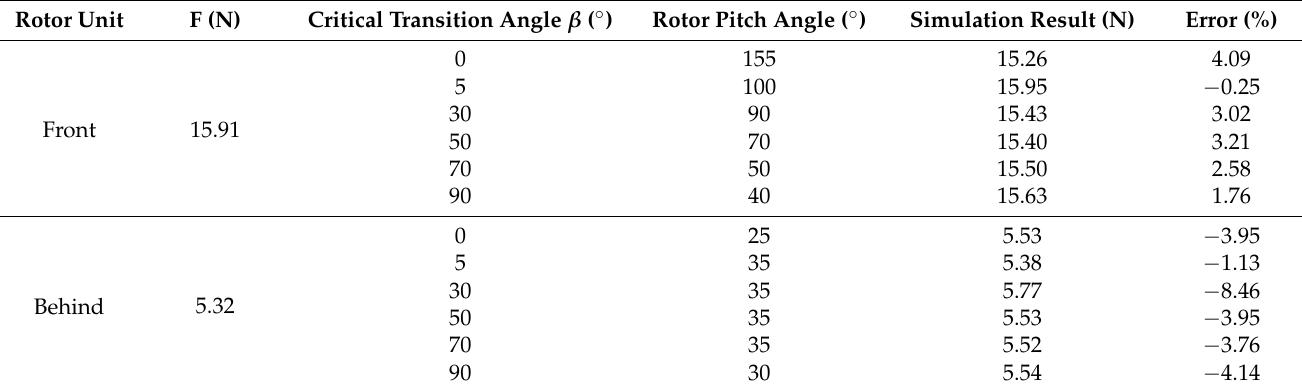
Table 3. Simulation analysis of aerodynamic coupling characteristics of adhesion